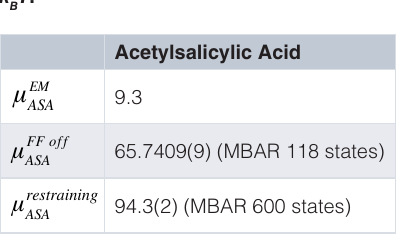
Table 3. Standard chemical potential of acetylsalicylic acid (ASA) at 298.15 K, in k T B